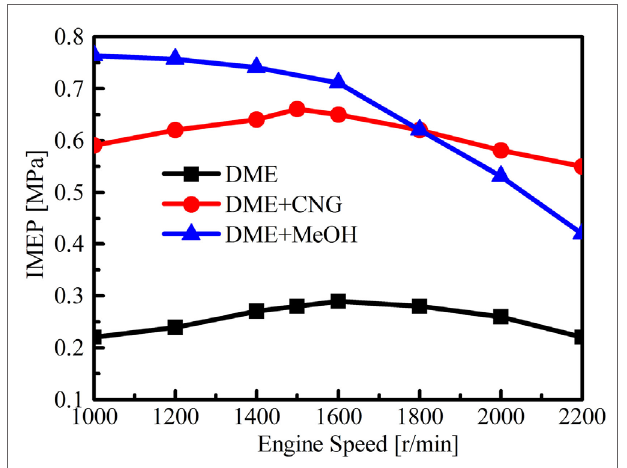
FiGURe 3 | Maximum operating loads that can be achieved using different fuel strategies in dual-fuel HCCi operation